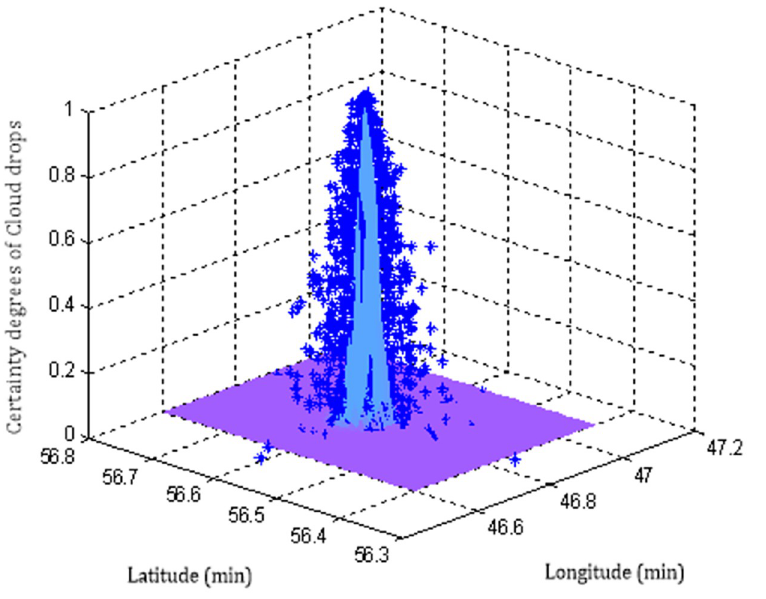
Fig 9. The expected surface of sampling point